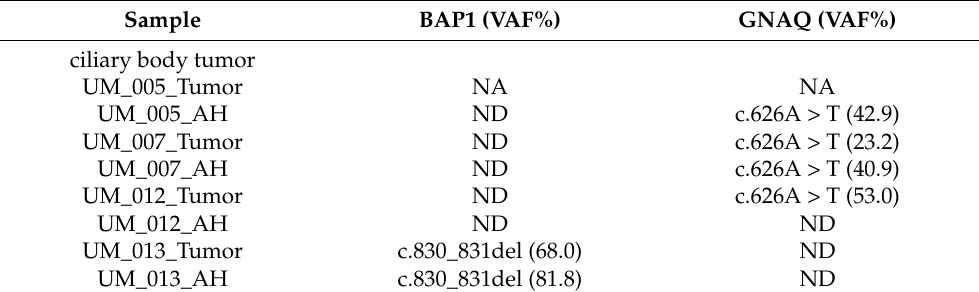
Figure 2. Somatic copy number alterations in UM post-radiation aqueous humor samples. ( A ) Schematic heatmap of the somatic copy number alterations (SCNA) in UM post-radiation AH sam- ples. Gains and losses of chromosomes are shown. ( B ) Comparison of SCNA status (altered/neutral) between choroidal UM ( n = 11) and ciliary body tumor ( n = 8) in post-radiation samples. P value was calculated by the Fisher’s exact test. ( C , D ) Altered SCNA profiles identified from 6 UM post-radiation AH samples (UM_005, 007, 012, 013, 014 and 019). Highly recurrent UM SCNAs (monosomy 3, 6p gain, 6q loss and 8q gain) are indicated with an * on DNA profiles. ( D ) Consistency of the copy number variation (CNV) profile between UM_019_pre, UM_019_post and its corresponding tumor wash sample. Pearson’s correlation coefficient compared at 5k bins between each sample is indicated. Table 2. Single nucleotide variant analysis of BAP1 and GNAQ in four CB